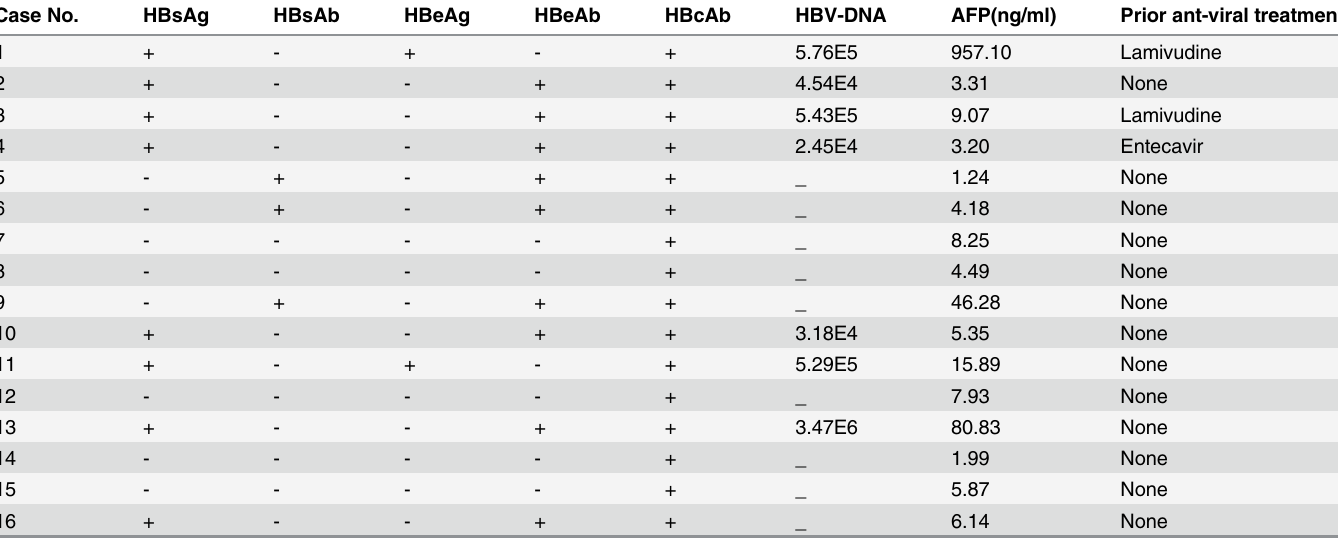
Table 5. HBV status at the diagnosis of second primary HCC and prior anti-viral treatment. Case